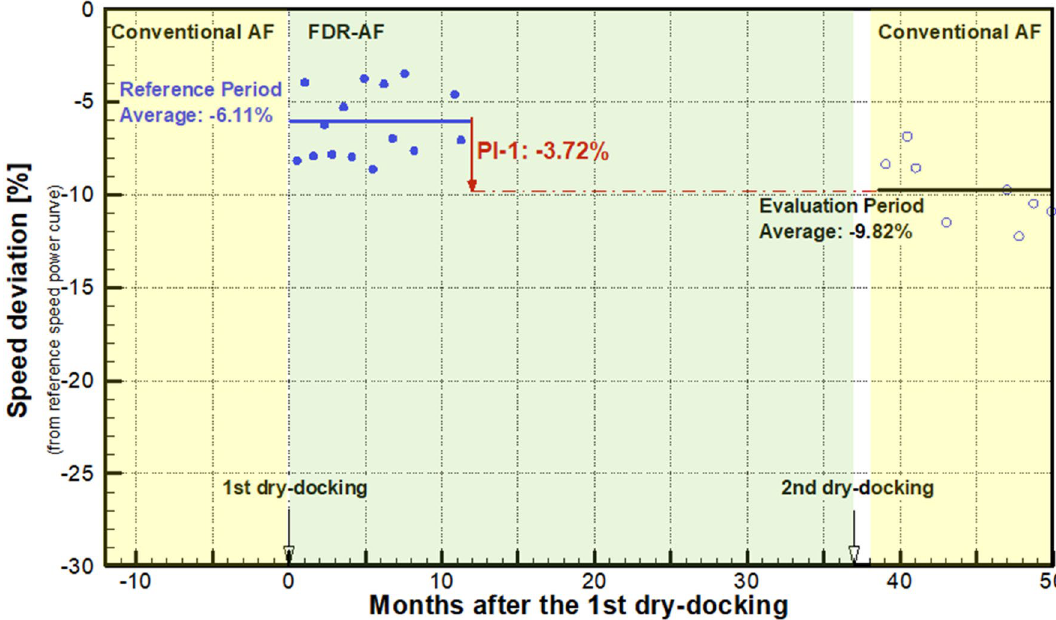
Figure 8. The AF coating effect quantified by the dry-docking performance (PI-1).